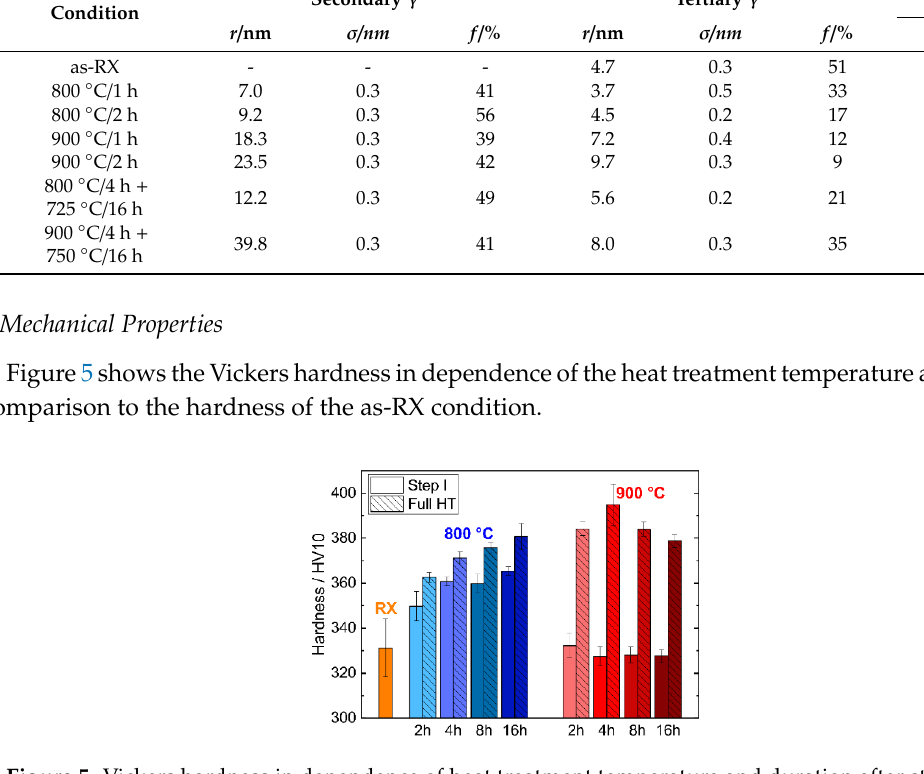
Table 4. Mean radius r and volume fraction f of secondary and tertiary γ (cid:48) precipitates of the heat treatments as determined by small-angle neutron scattering (SANS). The width parameter σ represents the broadness of the γ (cid:48) size distributions.